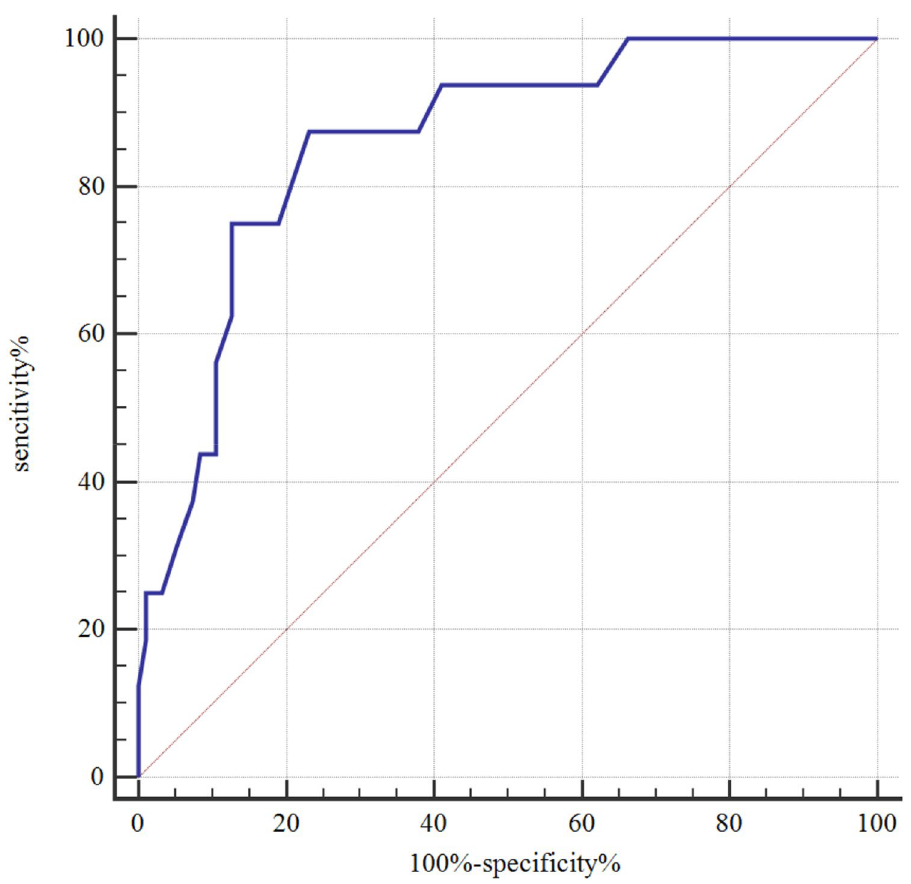
Figure 1. ROC curve of sOSCAR level for predicting MACE. Notes: ROC receiver operating characteristic; sOSCAR soluble osteoclast-associated receptor; MACE major adverse cardiovascular events.